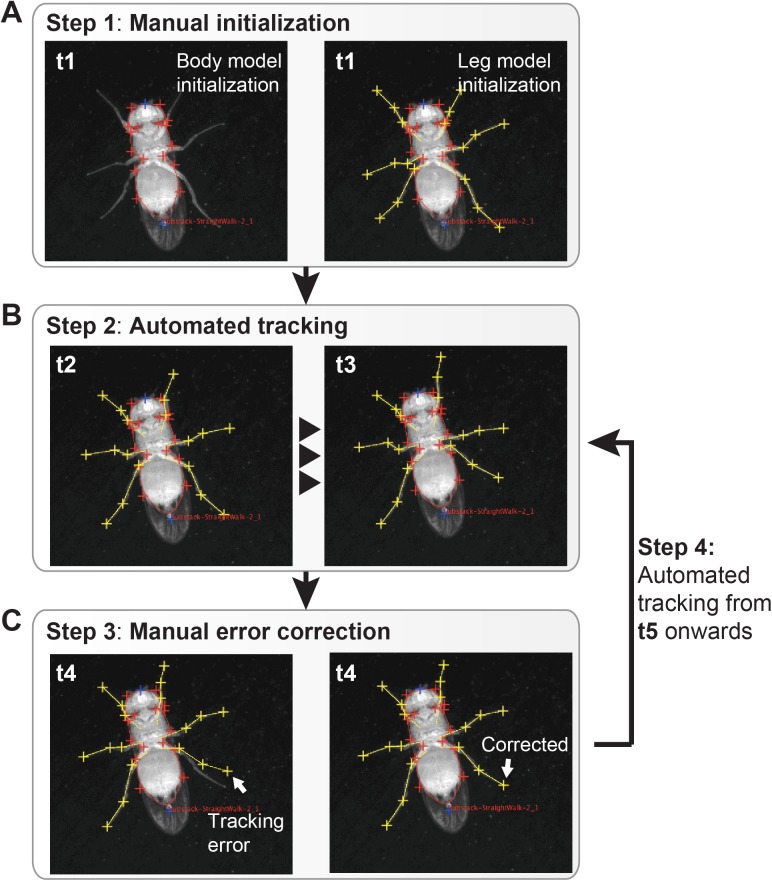
FlyLimbTracker workflow.(A) The user manually indicates the approximate location of the fly’s body in an arbitrarily chosen video frame (t1). FlyLimbTracker then optimizes a closed active contour model that encapsulates the fly’s body in the correct orientation. The user then manually indicates the location of each leg’s tip. FlyLimbTracker then optimizes an open active contour model that runs across the entirety of each leg. (B) The user then runs FlyLimbTracker’s automatic tracking algorithm to propagate body and leg models to subsequent video frames (or prior frames if run in reverse). (C) Either during or after automated tracking, the user can look for tracking errors. After manually correcting these errors, the user can re-run automatic tracking. In each image, the frame number is indicated.